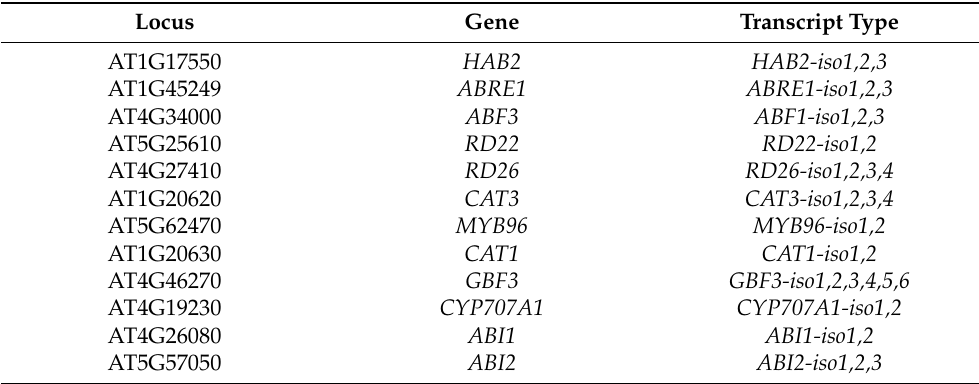
Table 2. Summary of the alternative splicing of genes in the ABA-induced abscisic acid (ABA) signaling pathway in Arabidopsis thaliana